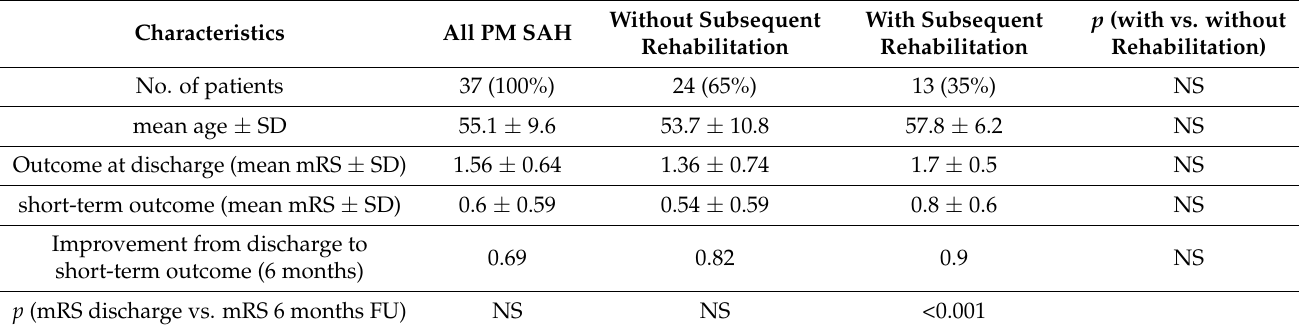
Table 2. Distribution of recirculated questionnaires and short-term outcome. Shown are patients’ age and outcome stratified by different subgroups: all PM SAH patients (n = 37), patients without subsequent rehabilitation (n = 24), patients with subsequent rehabilitation (n = 13) and a matched pair group of patients without subsequent rehabilitation (n = 13). To minimize the influence of selection, a matching procedure was necessary. WFNS grade and age were used as matching parameters. With Characteristics Rehabilitation